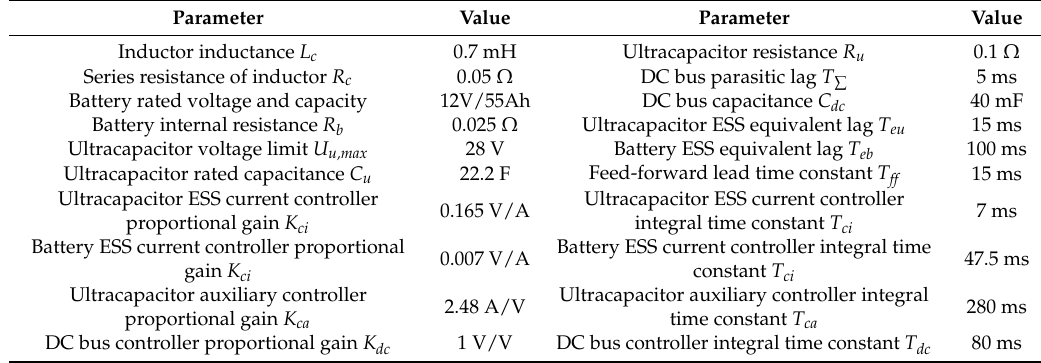
Figure 15. Principal schematic representation of DC bus control system down-scaled laboratory setup featuring three independently controlled DC/DC power converters, battery and ultracapacitor energy storages and variable load, and PLC-based DC bus control system and NI CompactRIO-based supervisory system. Table 3. Parameters of DC bus control system for down-scaled laboratory setup.